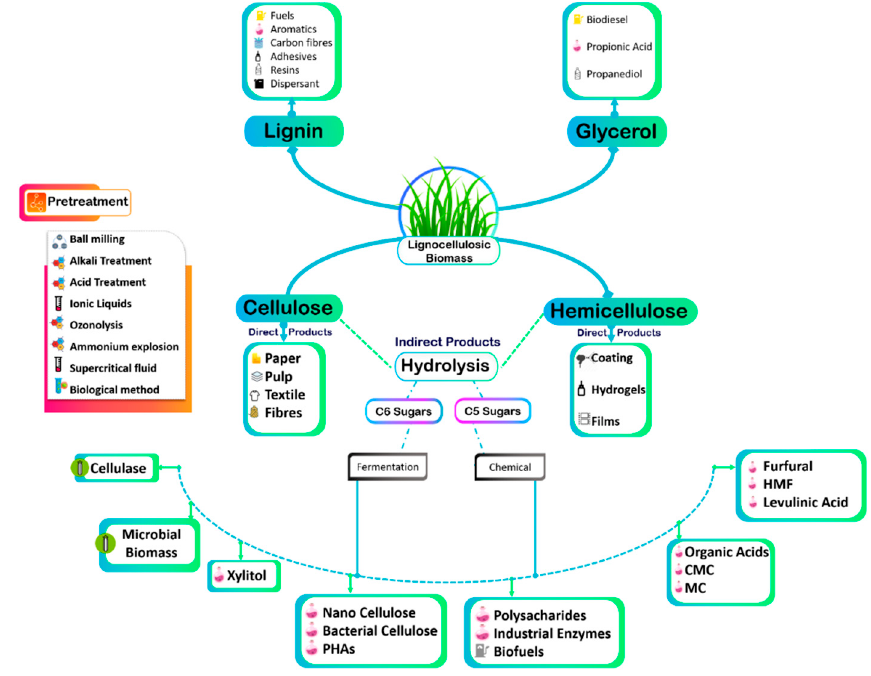
Figure 2. Various pretreatments involved in the fractionation of lignocellulosic biomass.